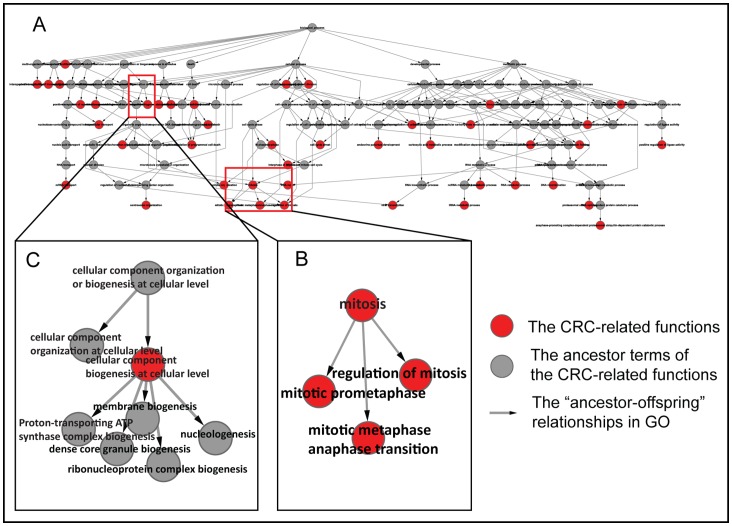
The CRC-related functions in the directed acyclic graph of Biological Process.
A. All the CRC-related functions. B. A case for both the ancestor and offspring terms retained simultaneously. C. A case for just one term retained in a biological process branch.